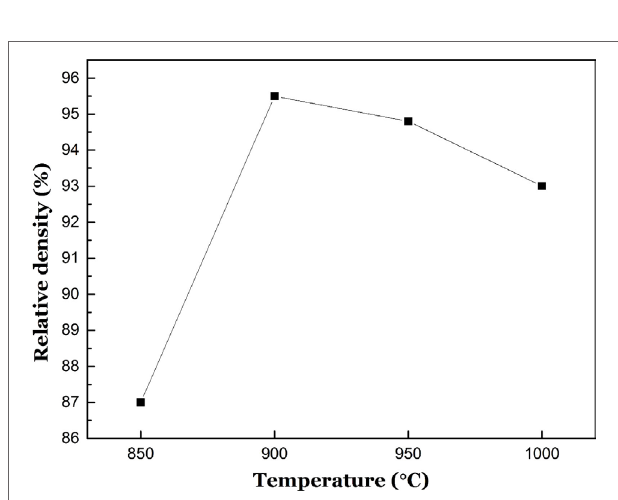
FigUre 2 | relative density of li 1.5 al 0.5 ge 0.2 Ti 1.3 (PO 4 ) 3 sintered at various temperatures .